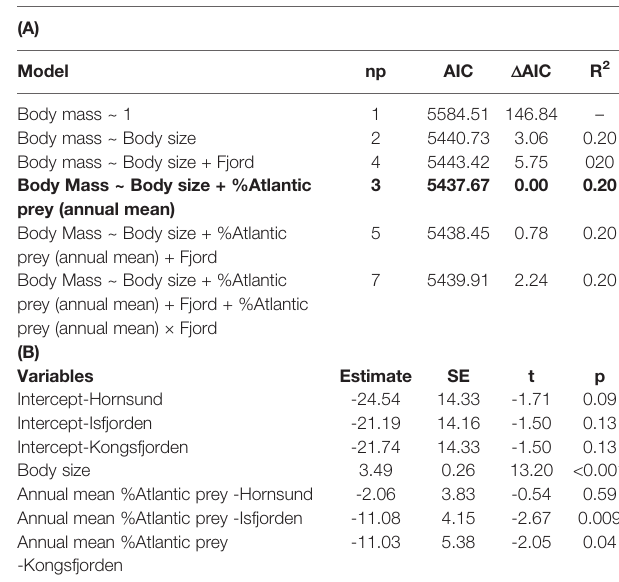
TABLE 4 | Effect of the mean annual proportion of Atlantic prey on body mass of adult little auks breeding in three western Svalbard fjords (Hornsund, Isfjorden and